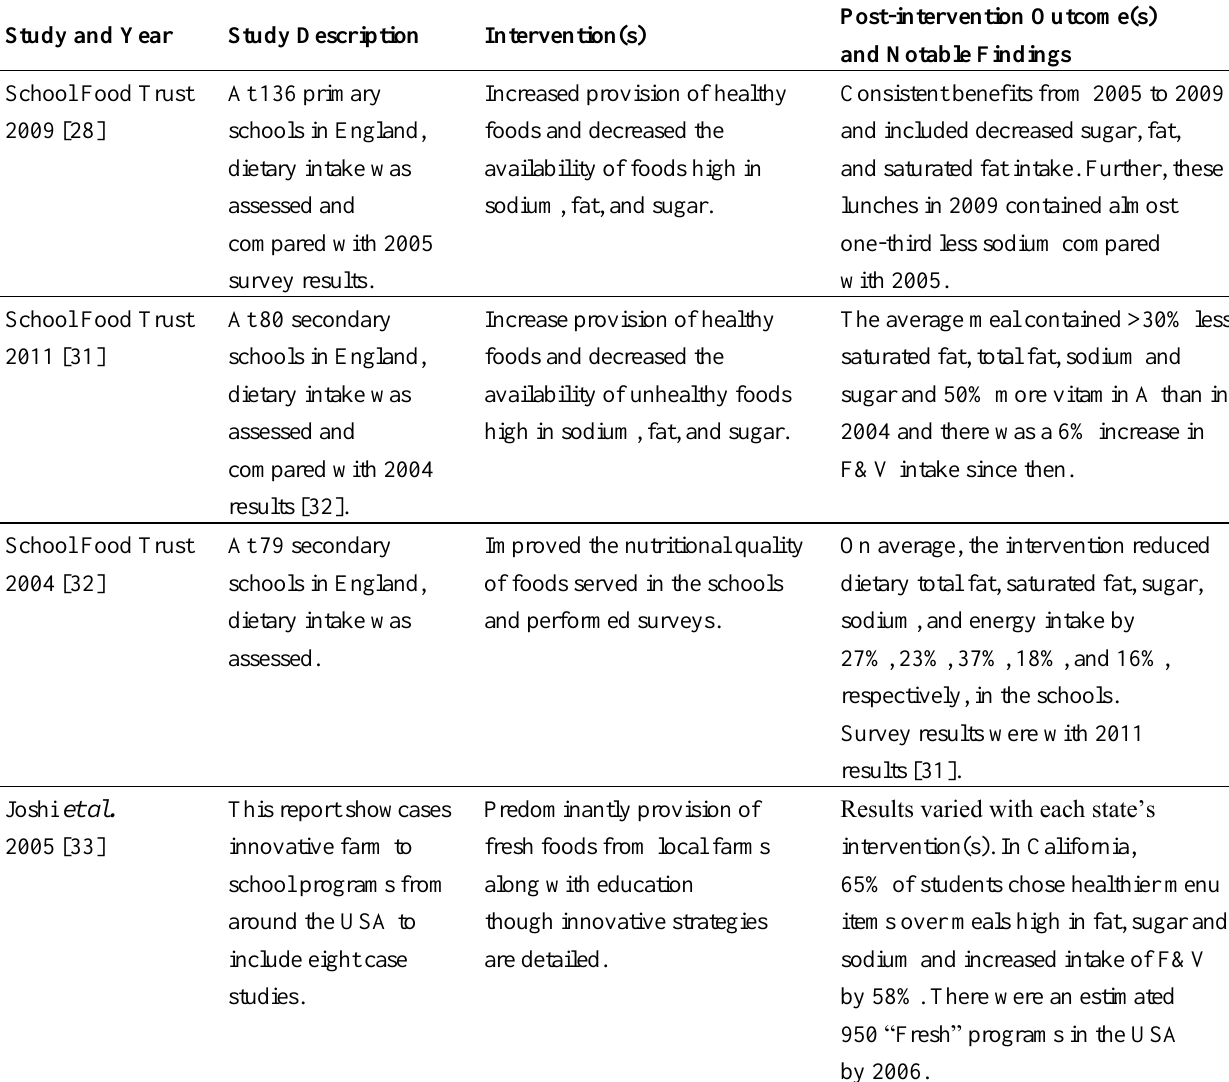
Table 1. Healthy Food Procurement Programs in